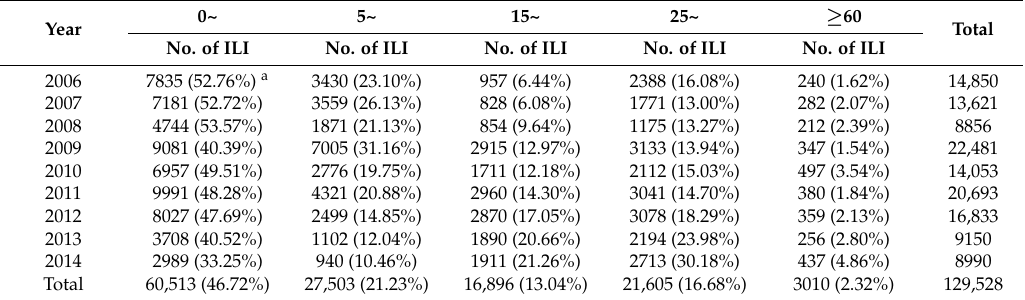
Table 1. Distribution of the influenza-like illness cases by age group in Ningbo, China,